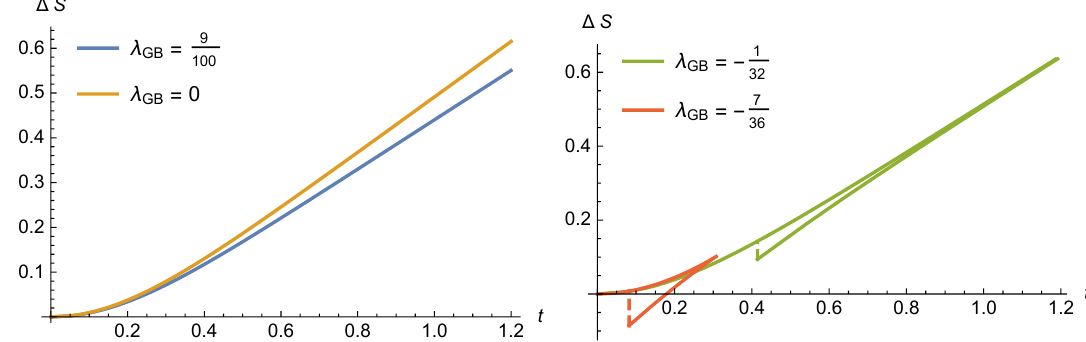
Figure 11 . Time evolution of extremal surface ‘area’ associated with the extremal surface passing through the horizon for d = 4 . The extremal surface ‘area’ (orange, blue and green lines) increases linearly with time at late times within the bound (4.23), i.e., λ GB ≥ λ c = − 1 / 32 . On the other hand, the extremal surface ‘area’ (red line) terminates growth and the extremal surface inside the horizon disappears after a finite time if the bound (4.23) is violated, i.e., λ GB = − 7 / 36 < λ c . Note that there is a zeroth-order phase transition of entanglement entropy at early times for the green line and red